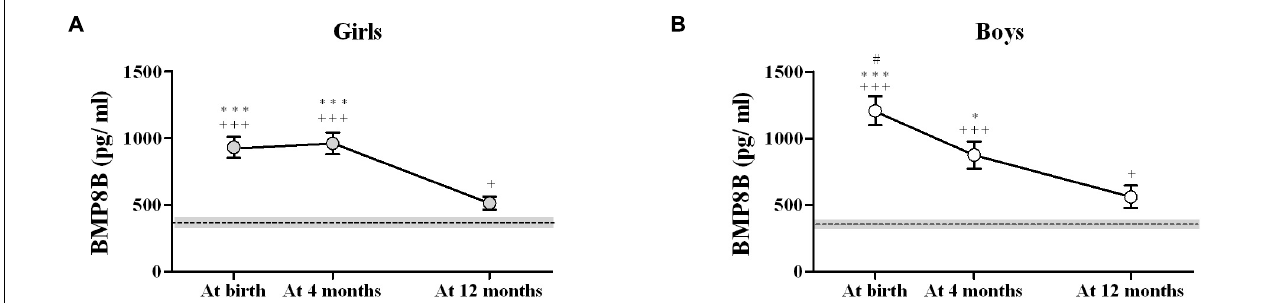
FIGURE 2 | Longitudinal results of circulating BMP8B concentrations in infant girls (A) and boys (B) . The dotted line depicts the mean values in apparently healthy adults ( N = 26; 15 women and 11 men); the shaded area represents the standard error (SEM) in those healthy adults. # P < 0.05 vs. 4 months; ∗ P < 0.05 and ∗∗∗ P < 0.001 vs. 12 months; + P < 0.05 and +++ P < 0.001 vs. healthy adults.